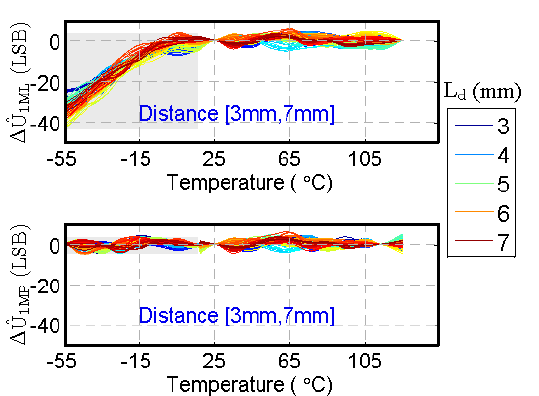
Figure 13. ∆ ˆU 1ML and ∆ ˆU 1MP with different { L x ,t } (at a low temperature, ∆ ˆU 1MP of the proposed method is closer to zero than ∆ ˆU 1ML , which demonstrates that the proposed system can obtain more accurate calculation of U 1